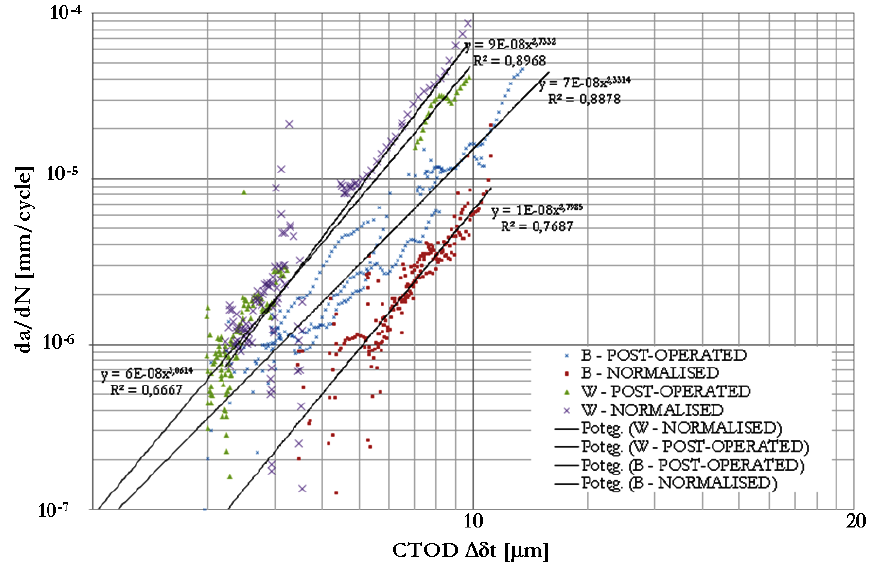
Figure 8: Kinetic fatigue fracture diagram for steel B and